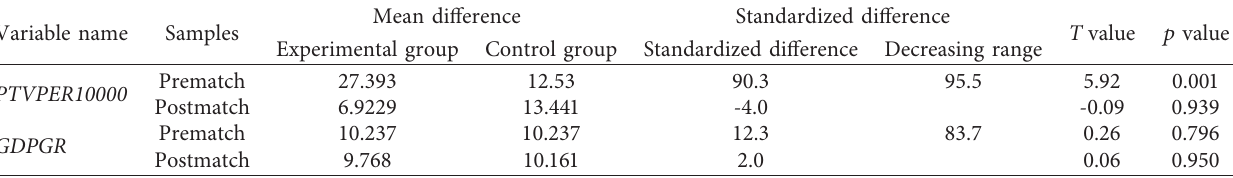
Table 7: Propensity score matching balance test results (2010–2016).